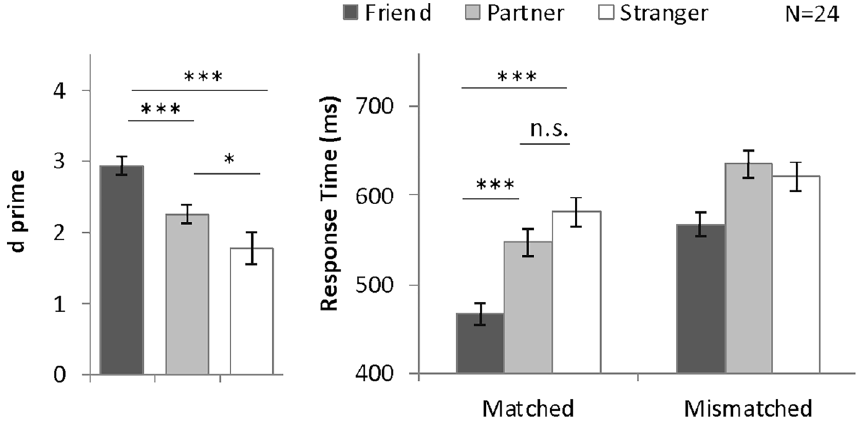
Figure 3. Mean and SE of d ′ and RT for different shape categories in Experiment 2A. * P < 0.05, ** P < 0.01, *** P <